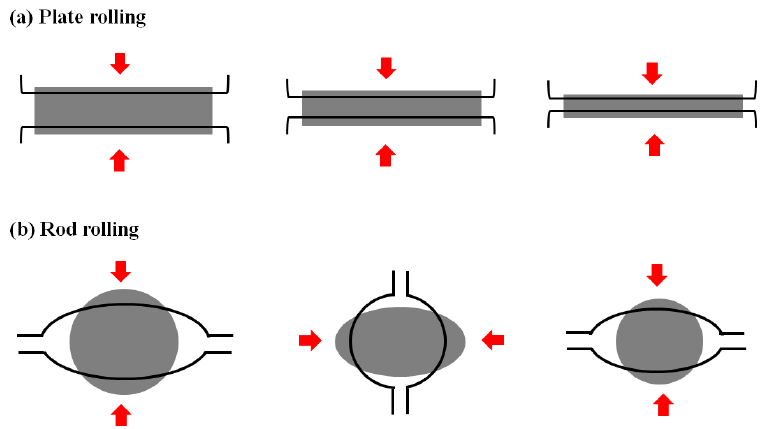
Figure 1. Schematic description of ( a ) plate and ( b ) rod during the rolling processes.